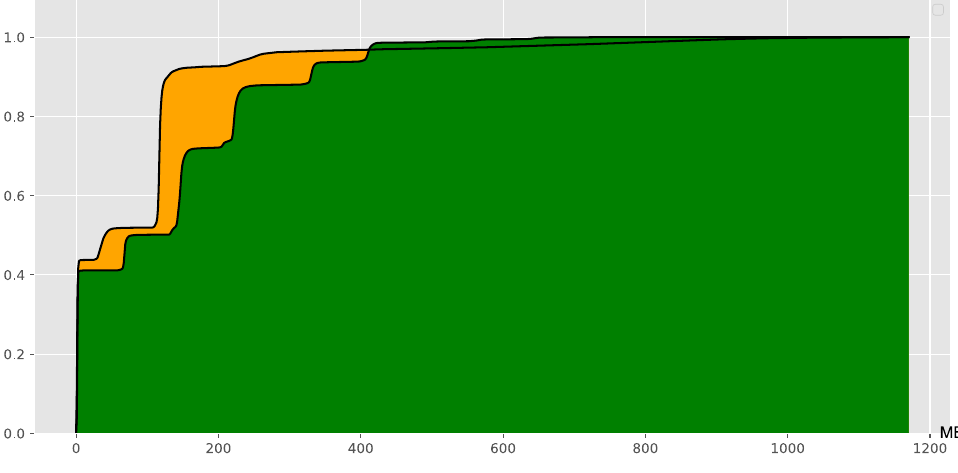
Figure 9. Probability Cumulative Curve of Request Latency (µs).